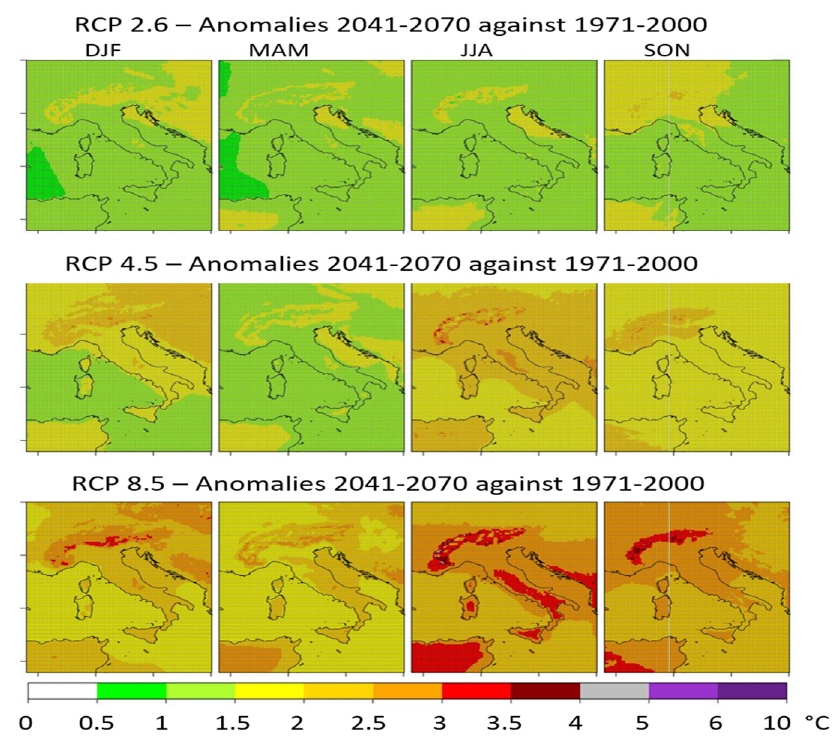
Figure 4. As Figure 3 but for anomalies expected by 2041–2070 against 1971–2000.